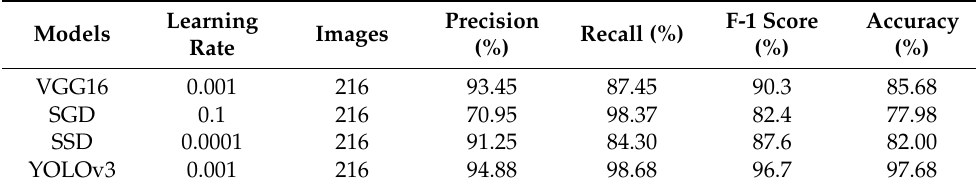
Table 4. Comparison of the accuracy results for the deep learning models used for hand gesture recognition. Best results are shown in bold.